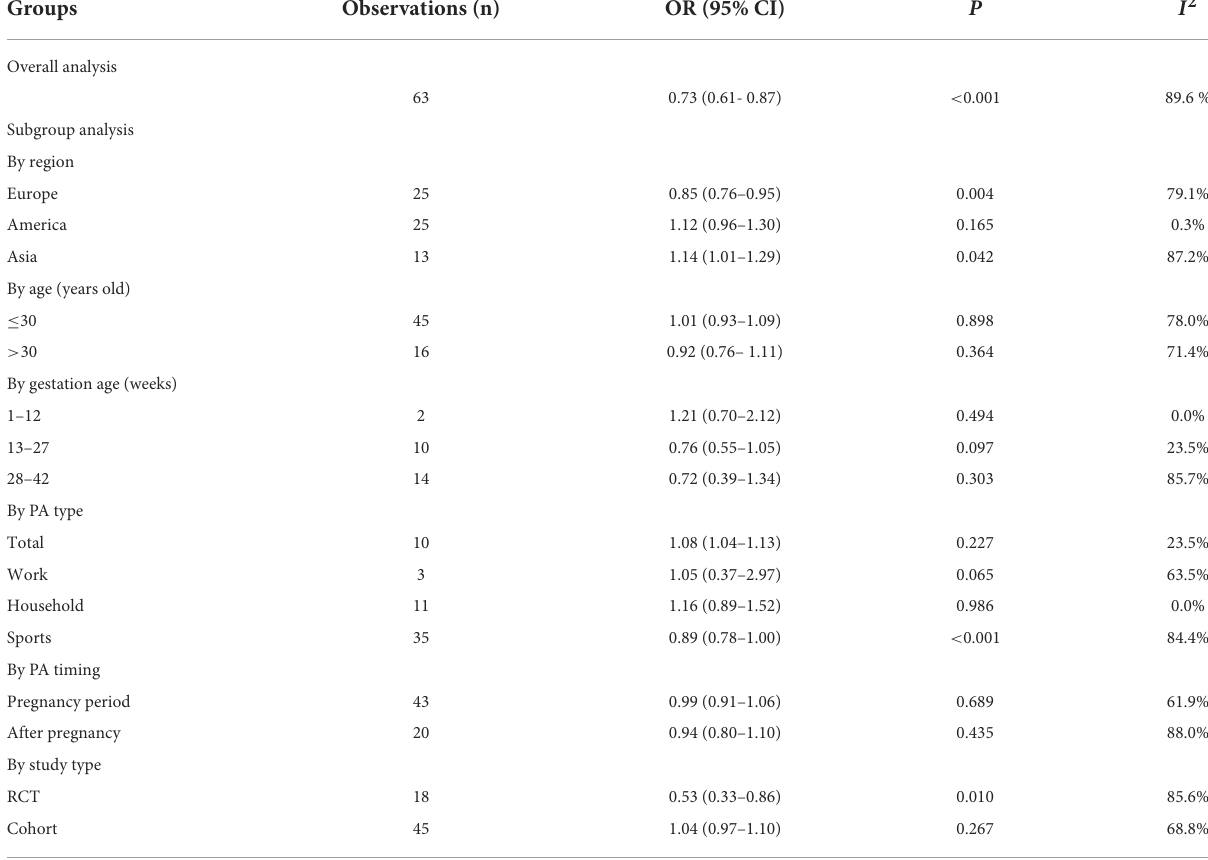
TABLE 3 Overall and subgroup analyses of the associations between physical activity and postpartum